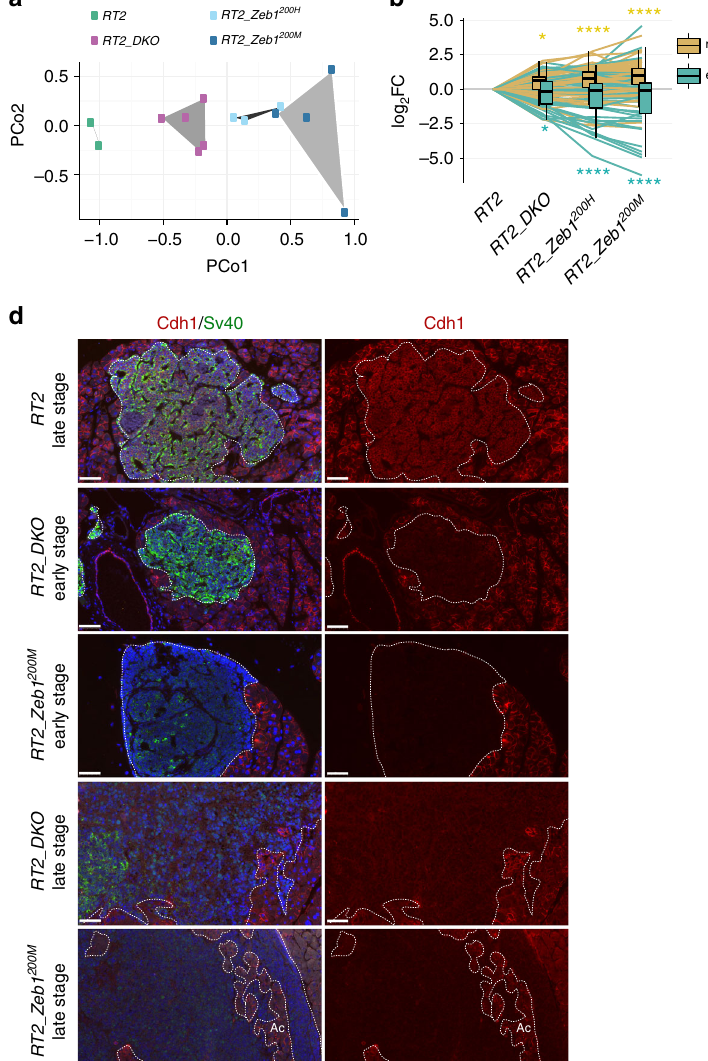
Fig. 4 miR-200-mediated Zeb1 regulation engages EMT program in vivo. a Principal coordinate analysis based on the expression of 122 EMT core genes in islets of 6-week-old mice. b Box-and-whisker plots (box, 25th and 75th percentiles; central line, median) of log 2 FC of mEMT or eEMT mRNAs in RT2_DKO, RT2_Zeb1 200H , and RT2_Zeb1 200M relative to RT2 . c CDH1 quanti fi cation in end-stage tumors (immunoblots shown in Supplementary Figure 3b) ( n = 10 – 13 tumors), normalized to β -actin and to calibrator sample. Data represent mean + SD. d Representative Cdh1 and SV40 immuno fl uorescence stainings of tumors (scale bar = 50 μ m). Tumors are outlined with dotted lines. Ac, Acinar cells. a , b RNA sequencing of islets of 6-week-old mice ( RT2 , RT2_DKO , RT2_Zeb1 200H , RT2_Zeb1 200M , n = 2, 5, 3, 4 mice, respectively). Signi fi cance was evaluated by b competitive gene set test and c one-way ANOVA followed by Dunnett ’ s multiple comparisons test (vs. RT2 ). * P ≤ 0.05; **** P ≤